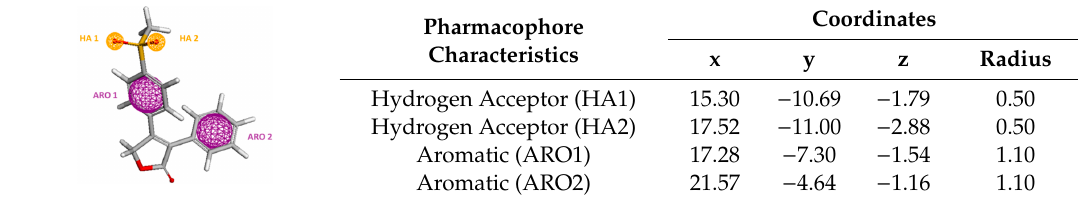
Table 6. Similarity studies of molecules using the Tanimoto Index .